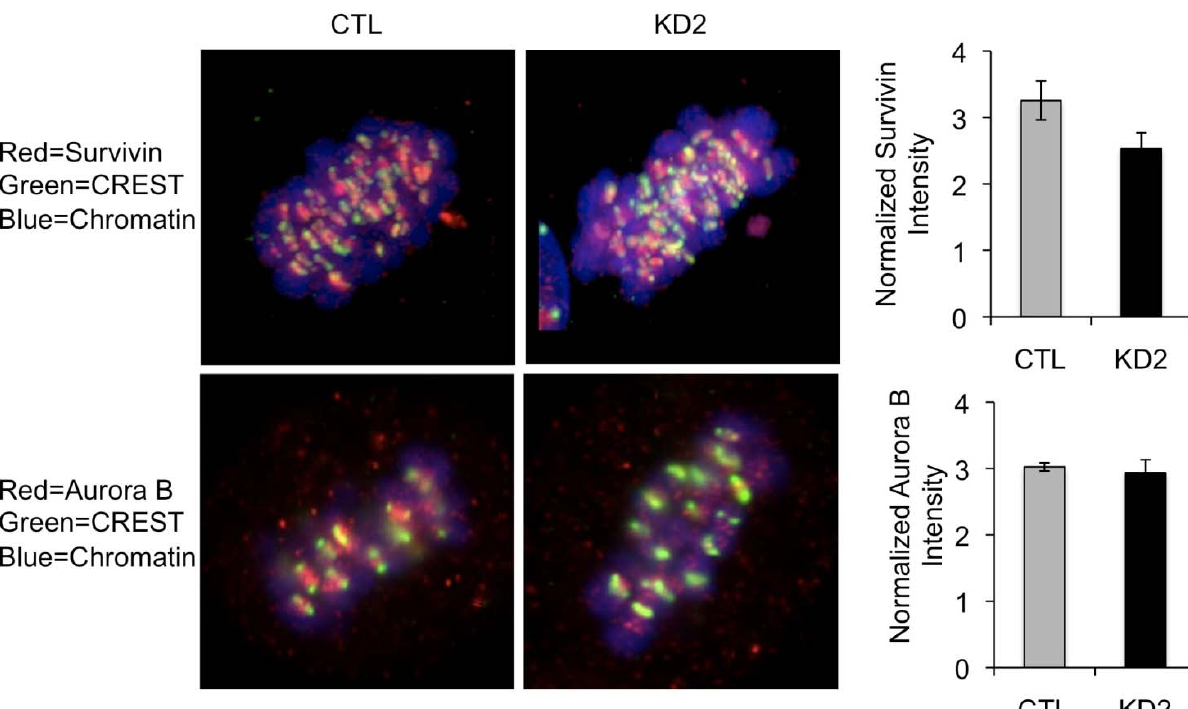
Figure 4. Localization of the CPC proteins Survivin and Aurora B at kinetochores in metaphase MCF-7 cells is not affected by p190B deficiency. Representative confocal images of metaphase control and p190B deficient MCF-7 cells immunostained with antibodies to detect Survivin, Aurora B, or CREST anti-serum are shown. Fluorescence intensities of Survivin and Aurora B normalized to CREST are graphed. Data is representative of at least 30 cells per group quantified from 3 independent